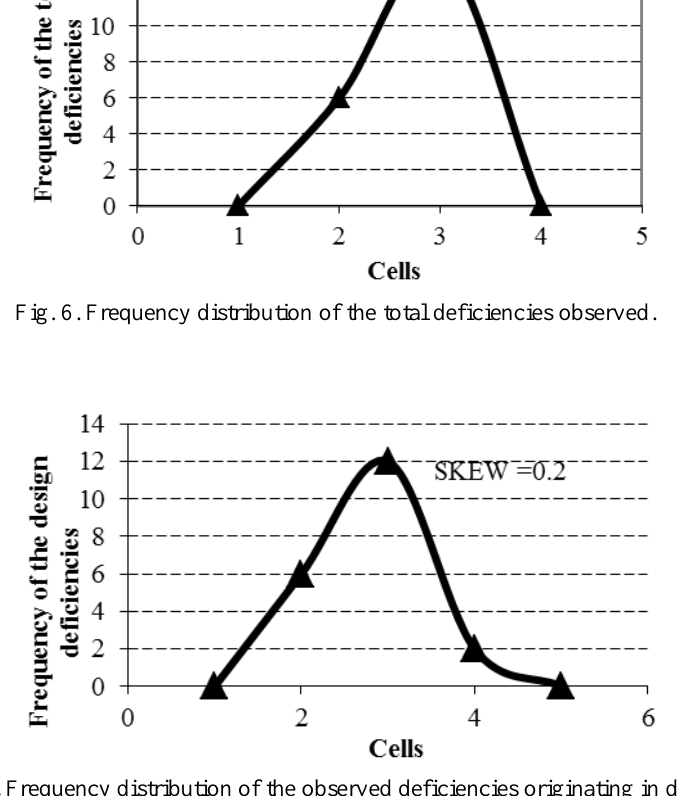
Fig. 7. Frequency distribution of the observed deficiencies originating in